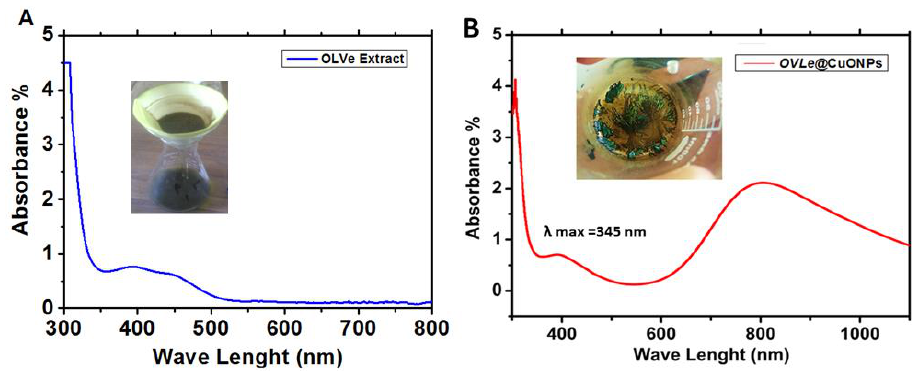
Figure 2. UV – Vis absorption spectra: ( A ) Olive leaf extract (OVLe), ( B ) CuO @OVLe NCs.